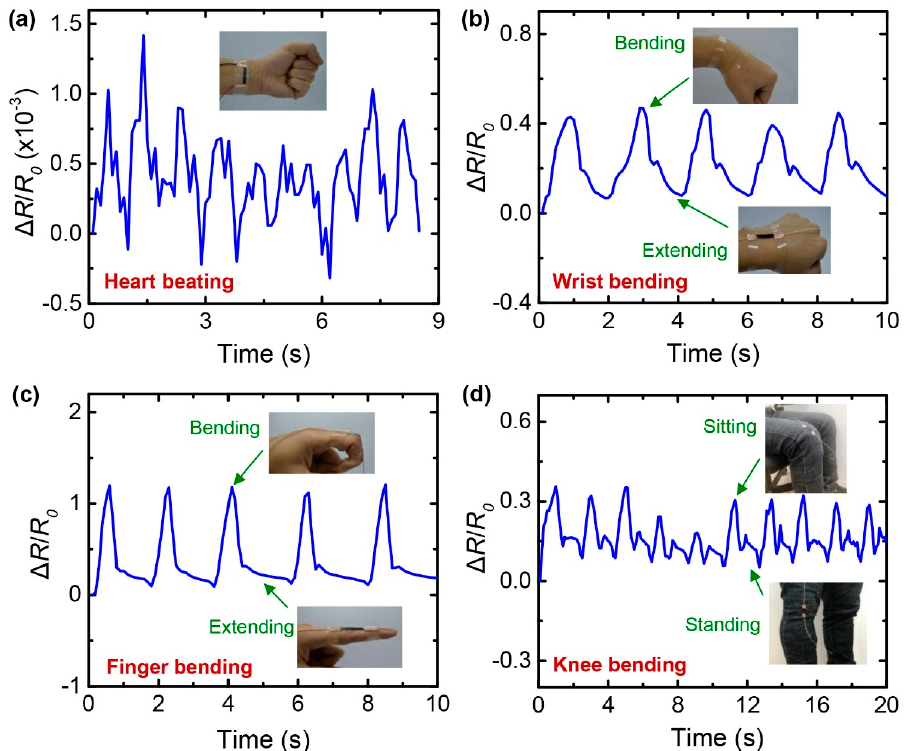
Figure 9. Real-time monitoring of various human motions using stretchable G/AgNW/SpX composite strain sensors. Resistance responses of the sensors clearly indicate: ( a ) heartbeats at the wrist; ( b ) bending of the wrist; ( c ) bending of the finger; ( d ) movement of the knee joint.